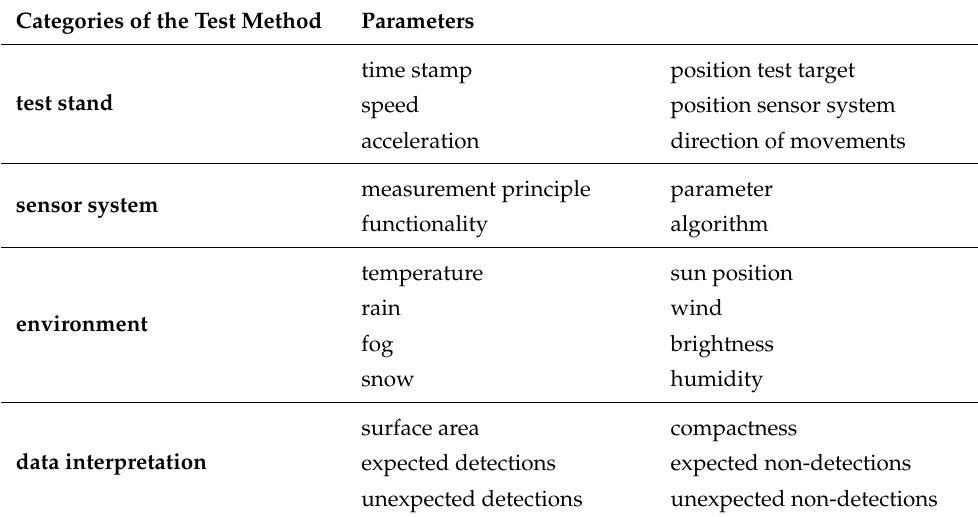
Table 9. This table represents the flexibility and variability of the new test method by a variety of test